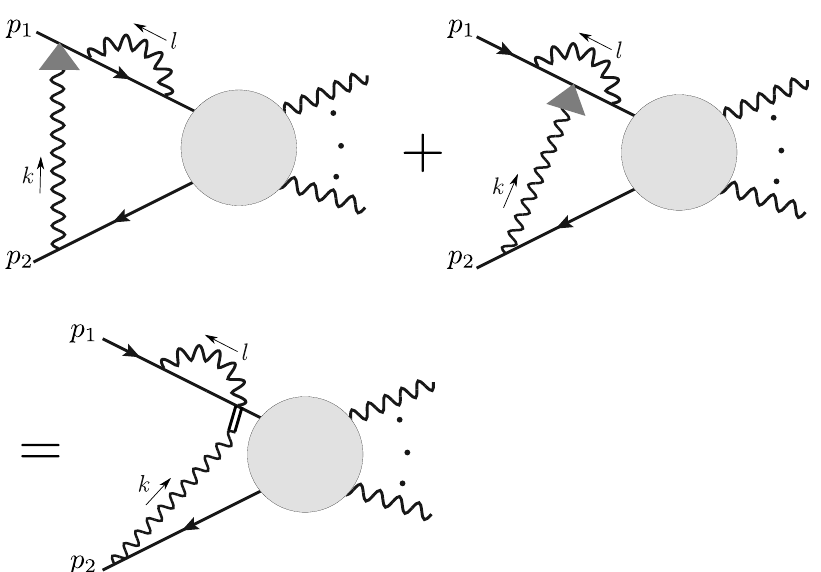
Figure 14. Illustration of the k k p 2 collinear singularities when summing type S and type V diagrams. The sum is a non-factorized collinear singularity at the integrand level, and vanishes only after integration.